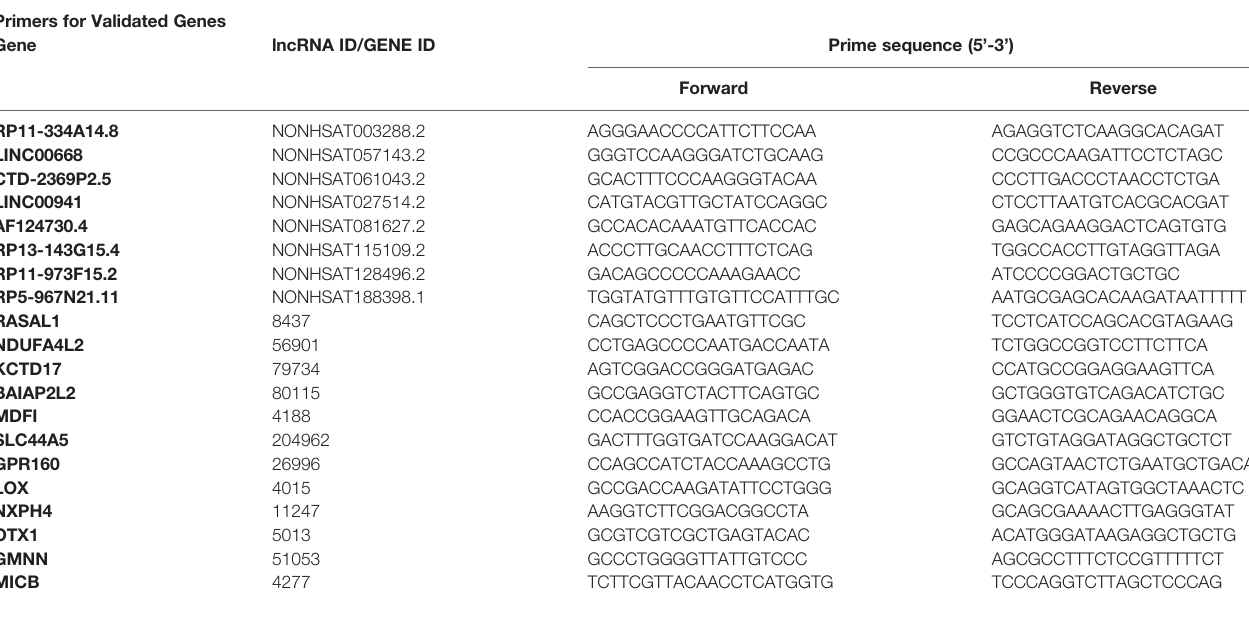
TABLE 2 | Primers of lncRNA and mRNA for